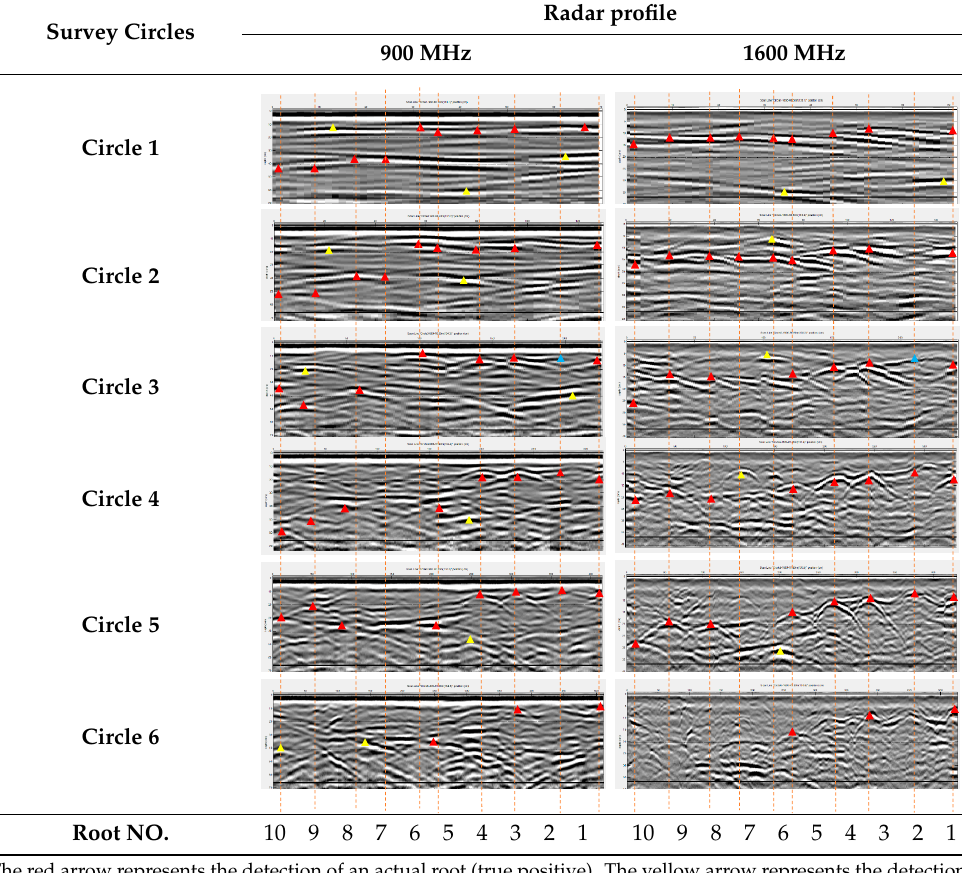
Table 7. Radar profiles of the simulated tree root experiment.